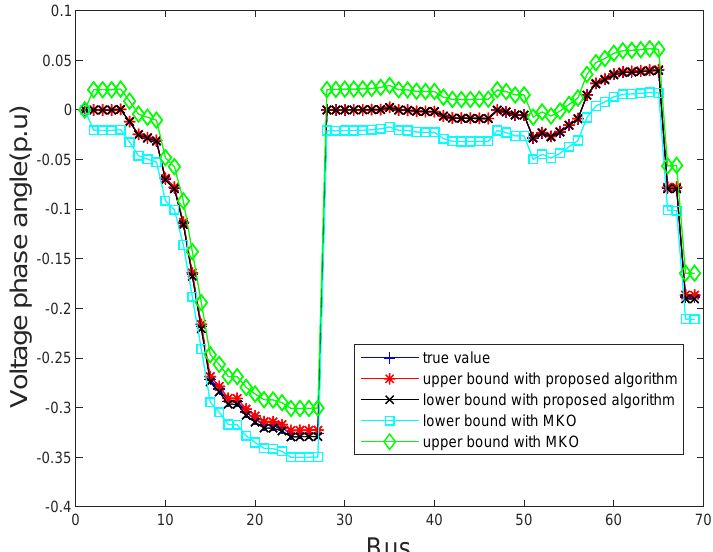
Figure 6. The estimated bus voltage phase angles obtained by the proposed algorithm and MKO on the IEEE 69 bus